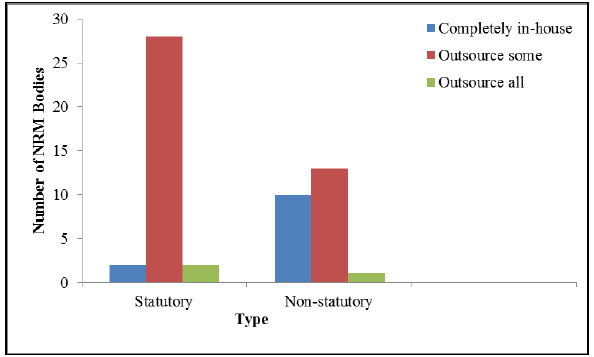
Figure 4: Mode of undertaking GIS activities